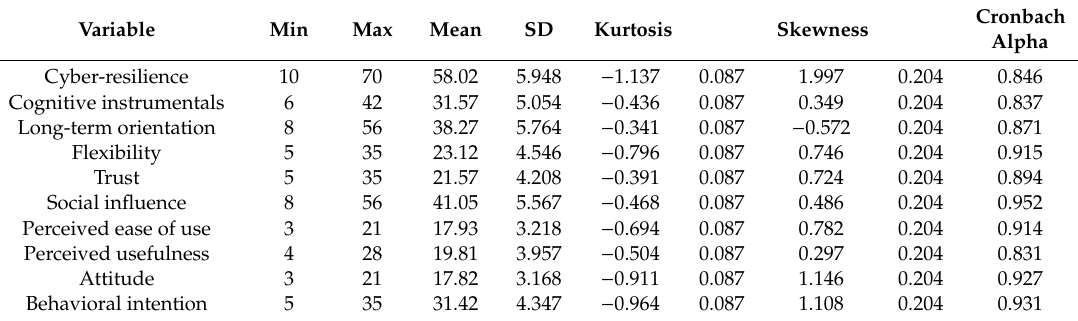
Table 3. Descriptive statistics of the latent variables and the reliability coe ffi